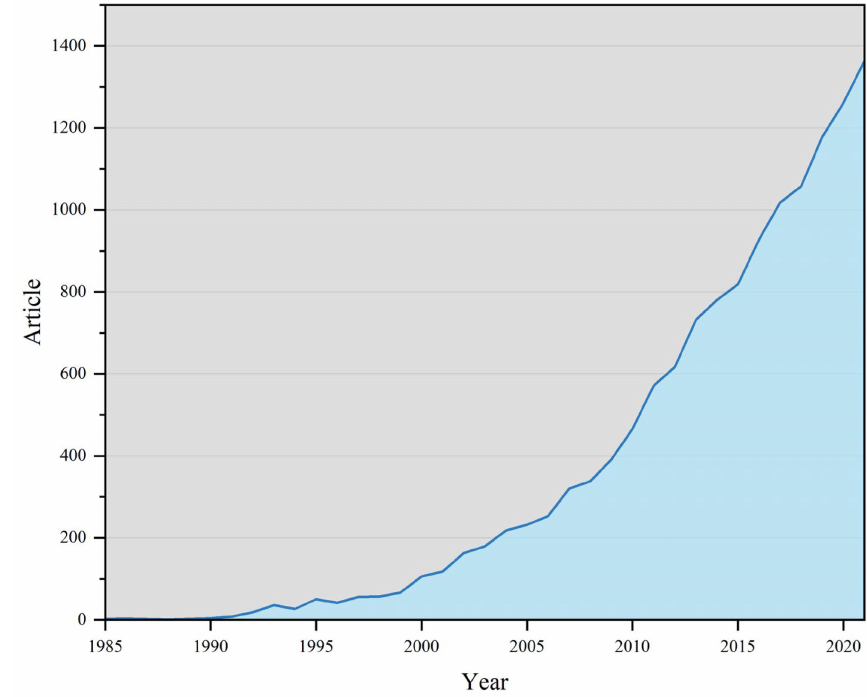
Figure 2. Impacts of Land Use Change on Soil Carbon Sequestration from 1985 to